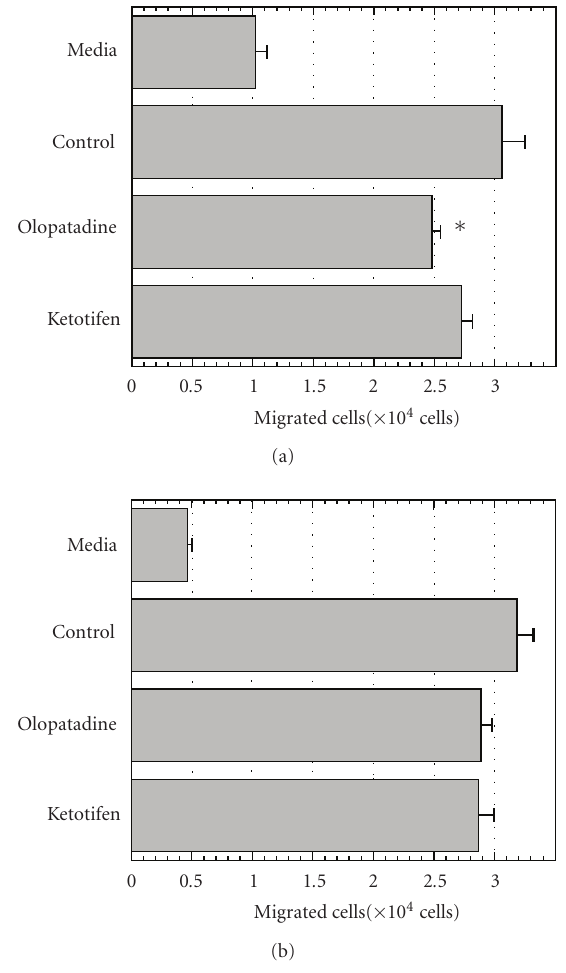
Figure 3: E ff ects of olopatadine or ketotifen on the migration of THP-1 cells induced by S100A12 (a) or RANTES (b). The num- bers of cells migrating toward S100A12 (1 μ mol/L) or RANTES (10nmol/L) during 3 h incubation were counted. Values are means ± SE from 2 independent experiments ( n = 6). ∗ P < 0 . 05 (versus control, Student t test). Media, spontaneous